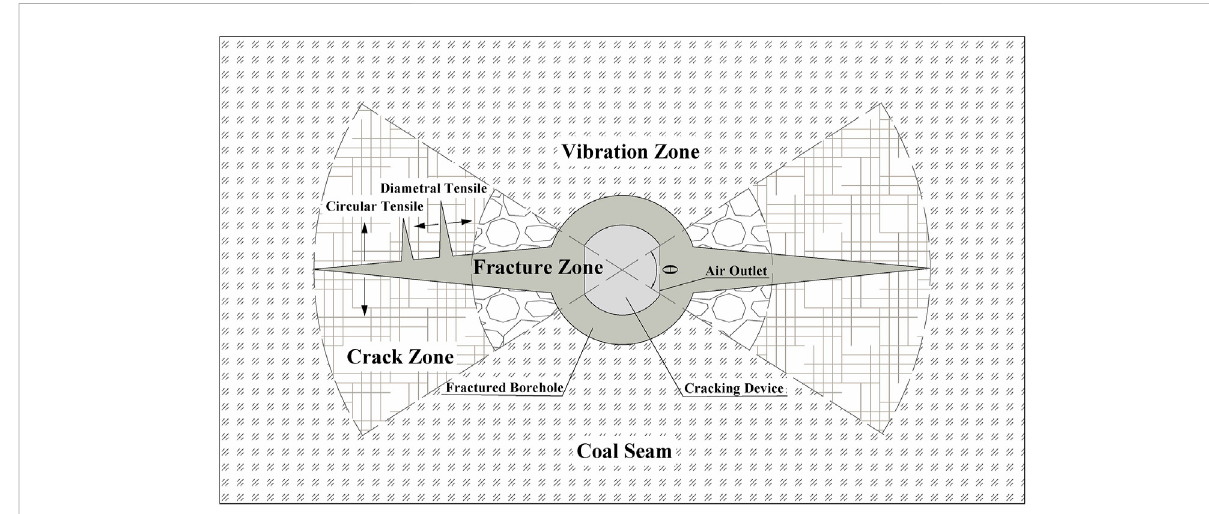
FIGURE 8 Comparison diagram of fracturing effect of supercritical CO 2 in underground test borehole.